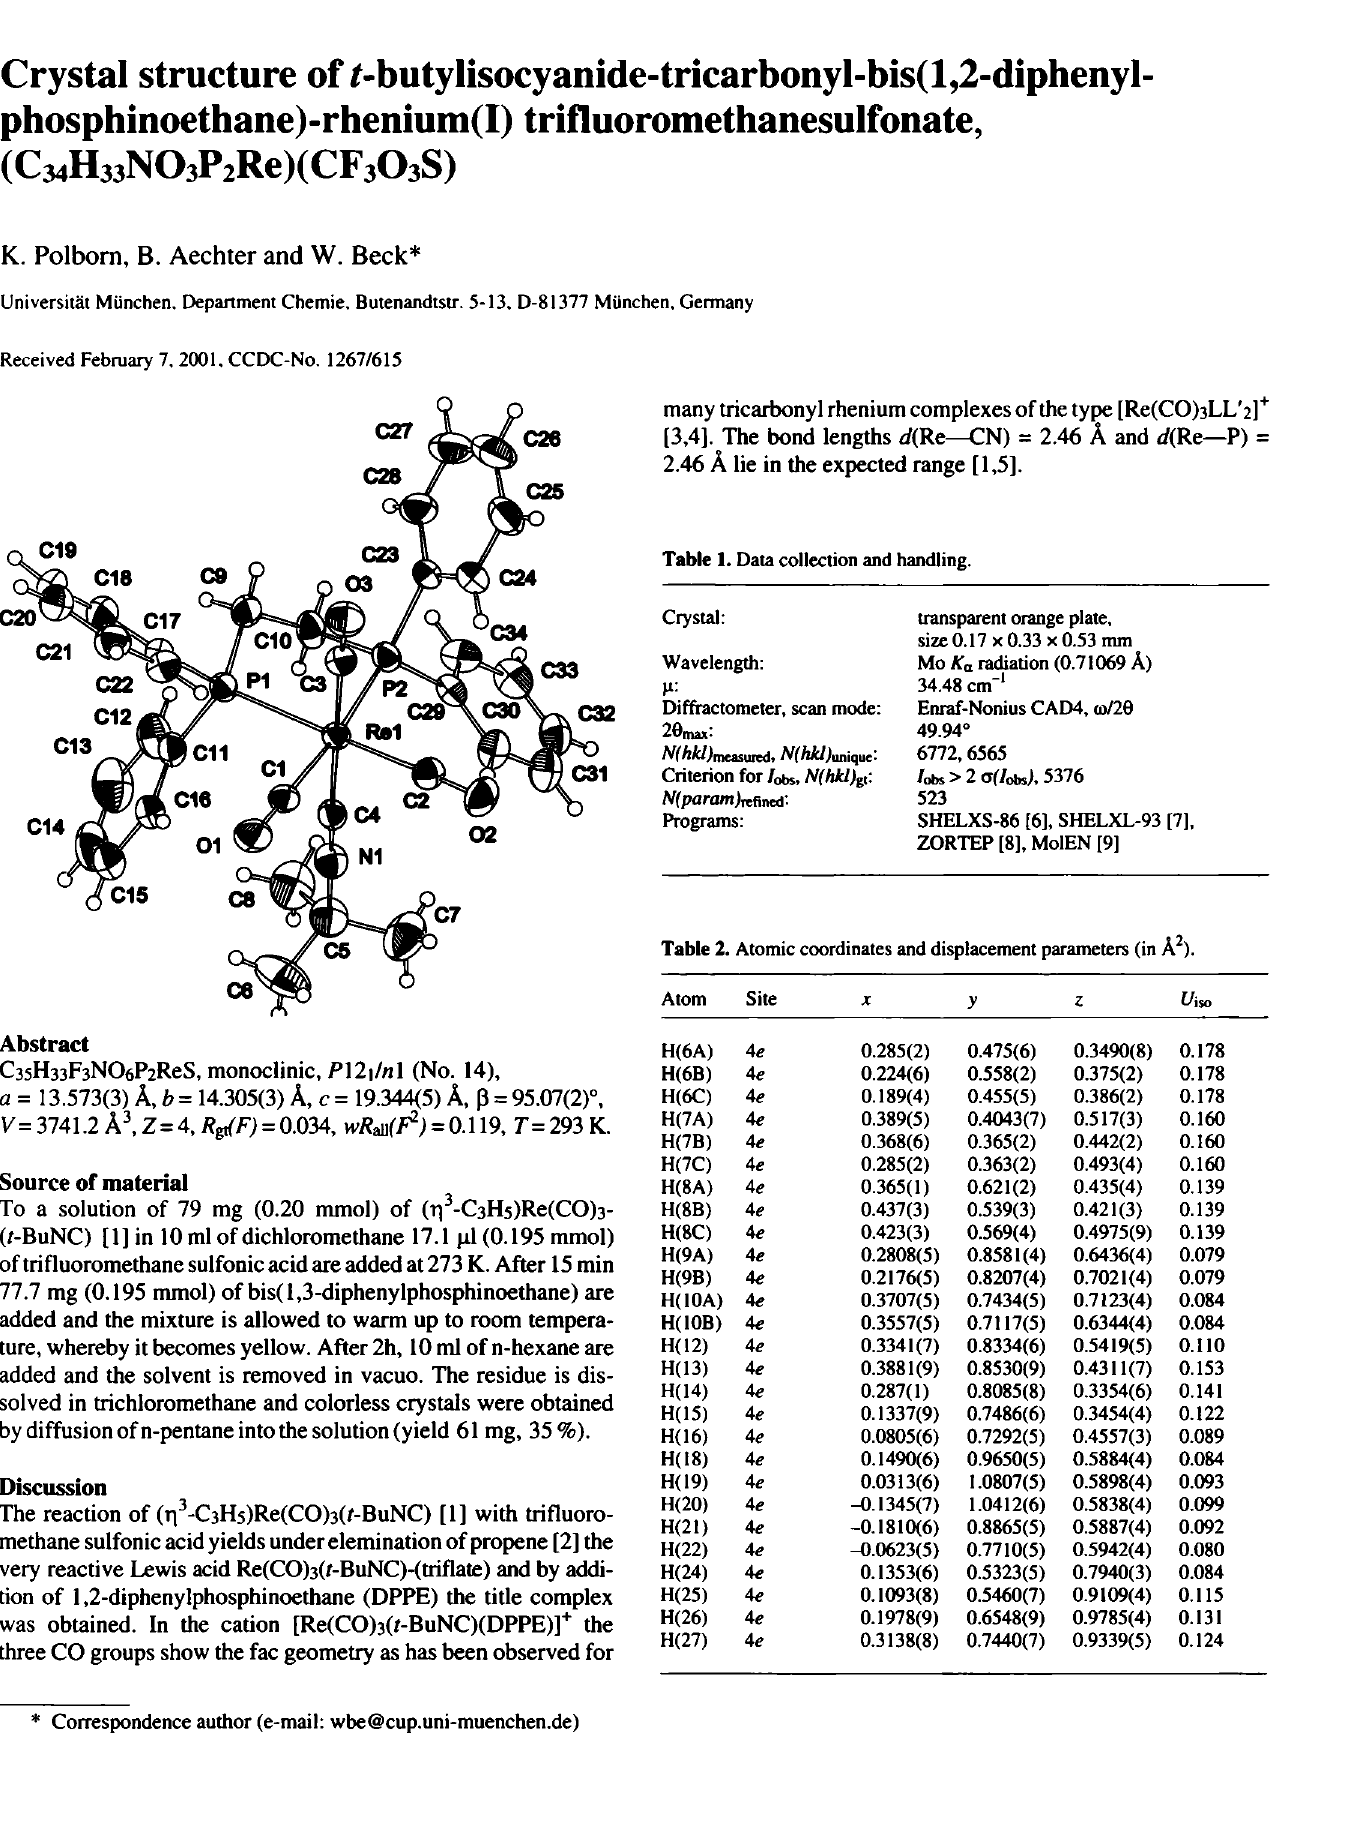
Table 1. Data collection and handling.